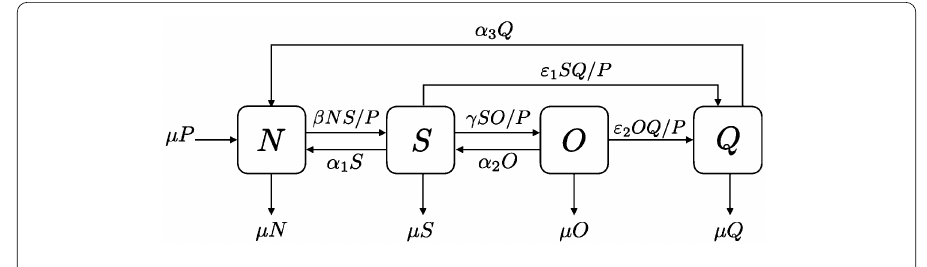
Figure 5 The dynamics of model